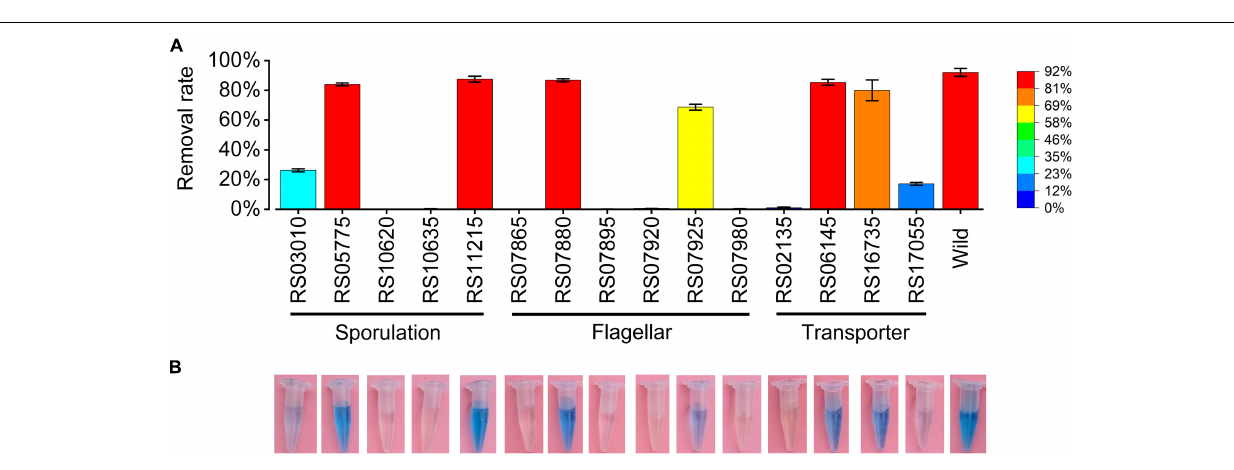
FIGURE 7 | Manganese oxidation ability of mutants. Mutants with deleted genes and the wild-type strain were cultivated in PYCM liquid media supplemented with 250 mg/L Mn(II) for 7 days. (A) Manganese removal rates of mutants detected by ICP-OES method. (B) Manganese oxidation abilities of mutants detected by adding 150 µ L of 0.04% LBB solution into the culture